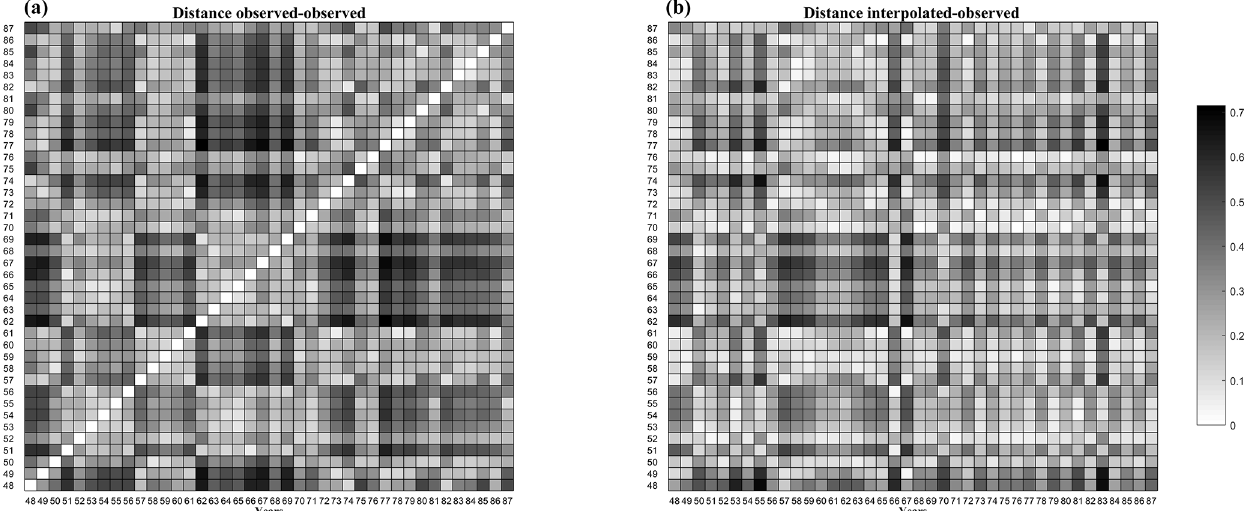
Figure 12. Kolmogorov–Smirnov distance between couples of streamflow values observed (a) and between couples of streamflow values observed and interpolated (b) at Tangipahoa River (FL) from October 1948 to September